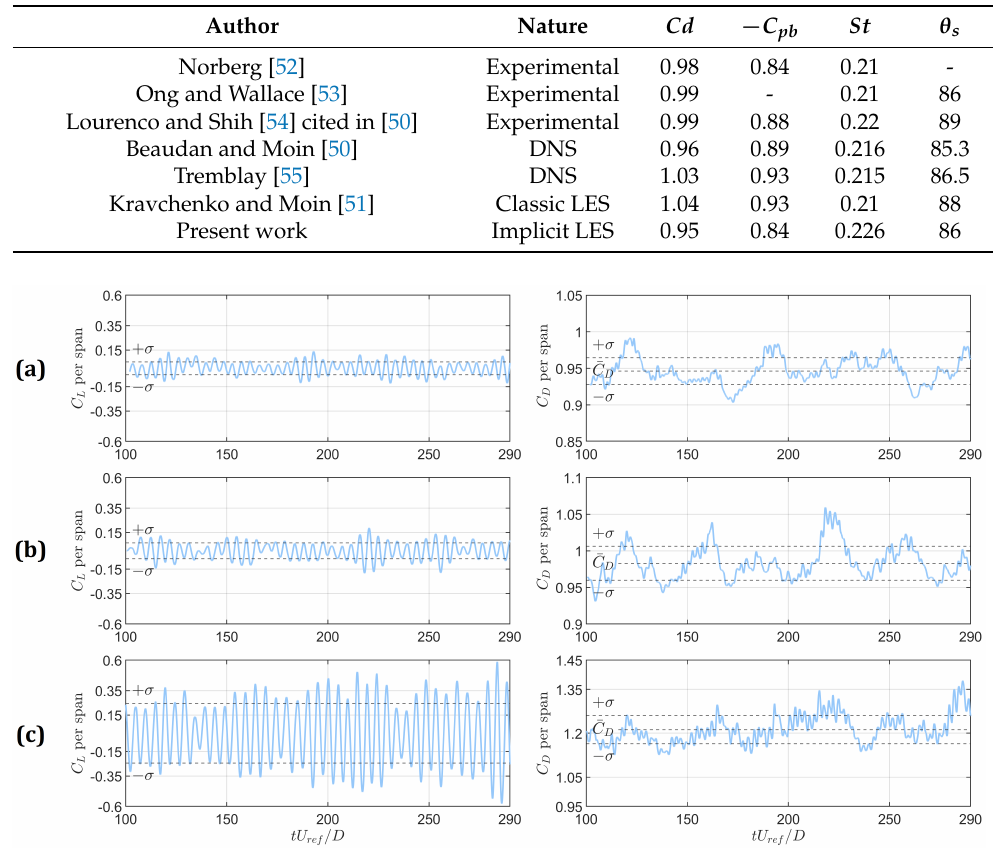
Figure 7. Histories of lift coefficient ( left ) and drag coefficient ( right ) for the baseline ( a ), A03 ( b ), and A11 ( c ) models.